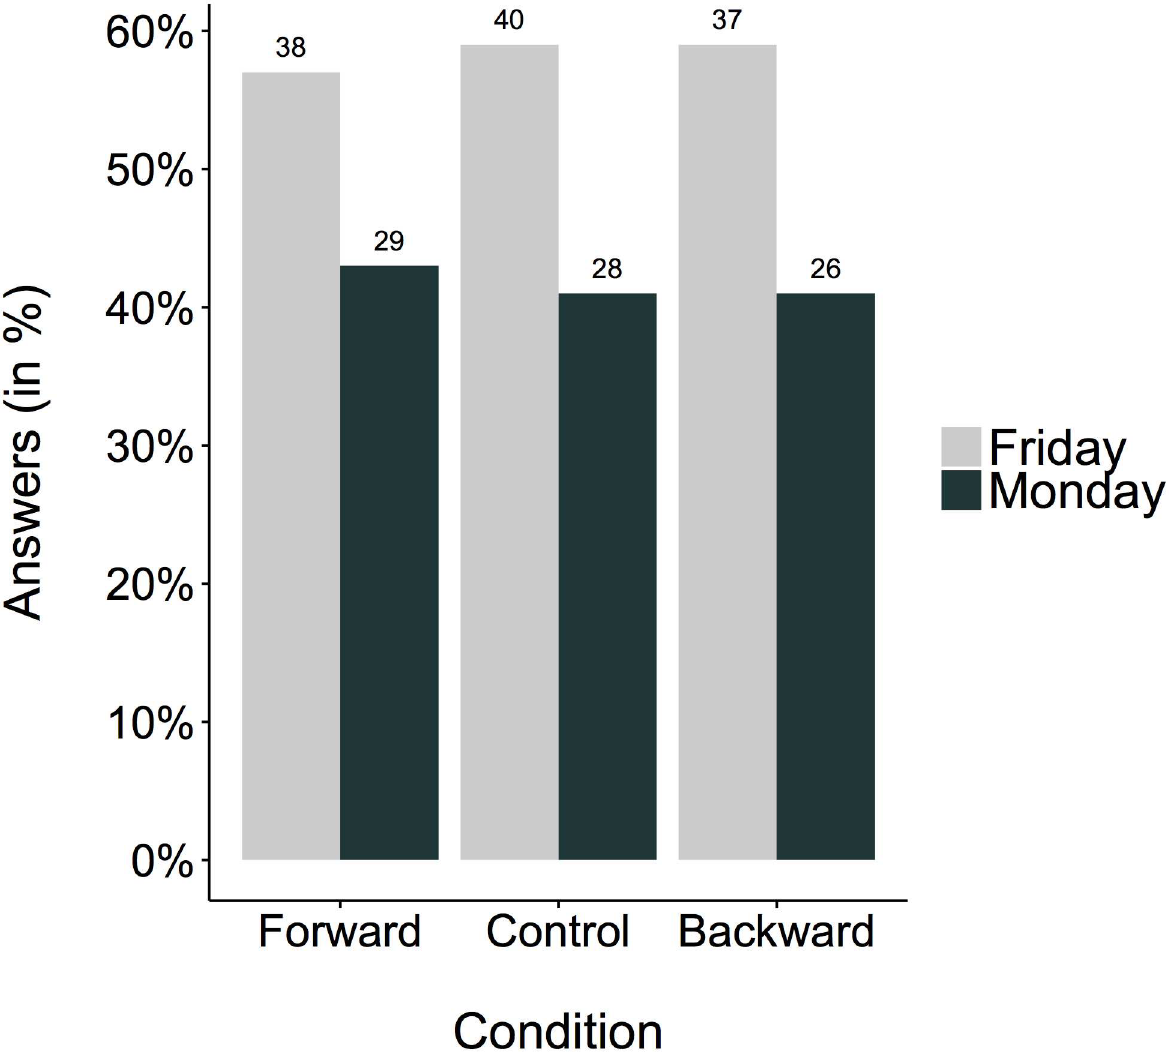
Fig 2. Percentage of Friday and Monday answers plotted for the three different groups (i.e., walking conditions). The total number of answersis printed above each